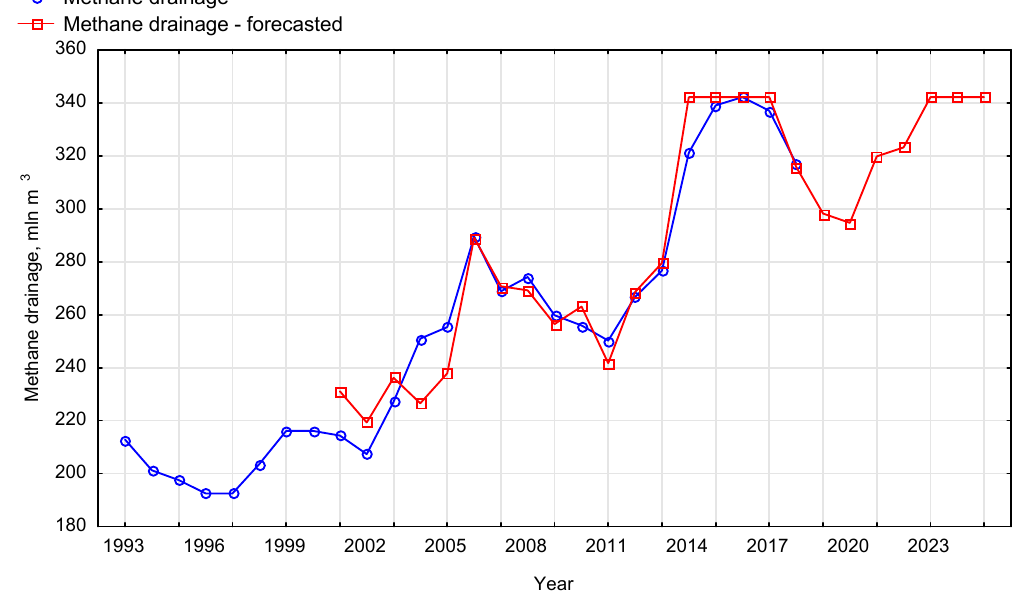
Figure 14. Actual and predicted amount of methane drainage.